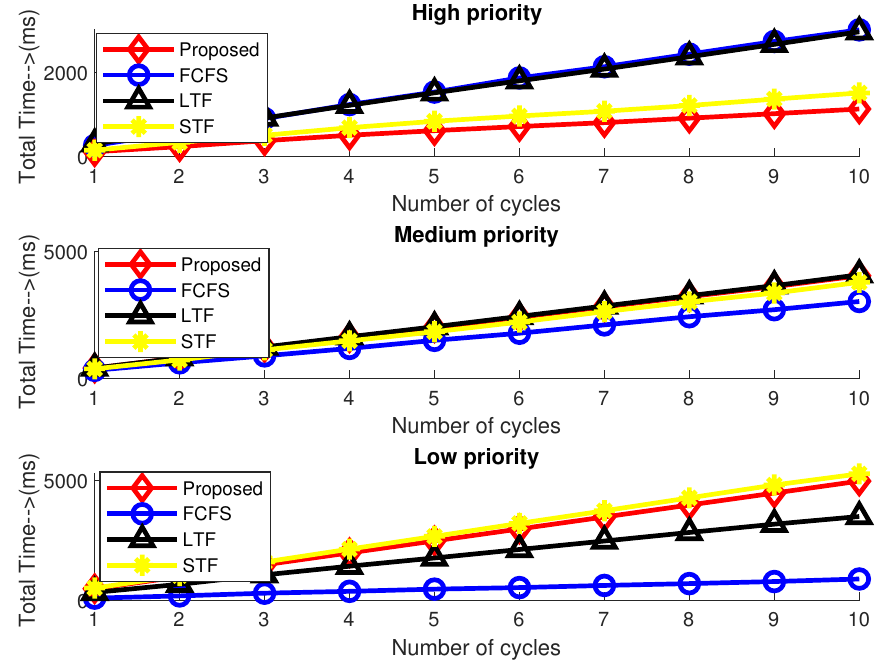
Figure 7. Accumulated processing task time for different processing